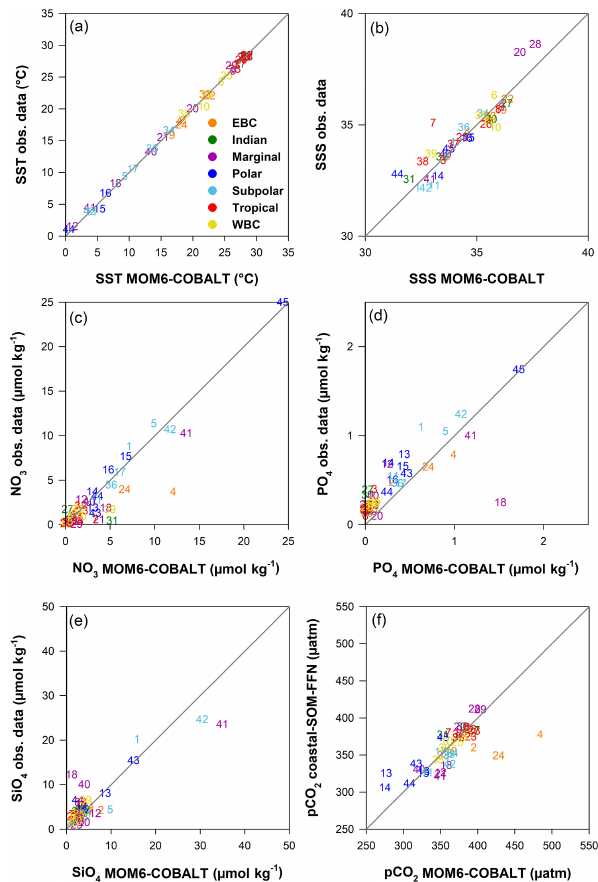
Figure 3. Comparison between observed and simulated annual mean fields in the 45 MARCATS regions: (a) SST ( ◦ C), (b) SSS (no unit), (c) NO 3 (µmolkg − 1 ), (d) PO 4 (µmolkg − 1 ), (e) SiO 4 (µmolkg − 1 ) and (f) p CO 2 (µatm). Observational datasets are as follows: SST and SSS are from the NOAA OI SST V2 (Reynolds et al., 2007) and the EN4 SSS (Good et al., 2013), nutrients are from the World Ocean Atlas 2018 (Garcia et al., 2019), and p CO 2 is from the coastal SOM-FFN product (Laruelle et al., 2017). Col- ors correspond to the seven major MARCATS classes (see Fig. 1b). In panels (d) and (e) , the Black Sea (M21) is not represented and has xy coordinates of (0.2; 3.5µmolkg − 1 ) in panel (d) and (10.3; 83.1µmolkg − 1 ) in panel (e) . The Antarctic shelf (M45) is also not represented in panel (e) (55.0;49.1µmolkg − 1